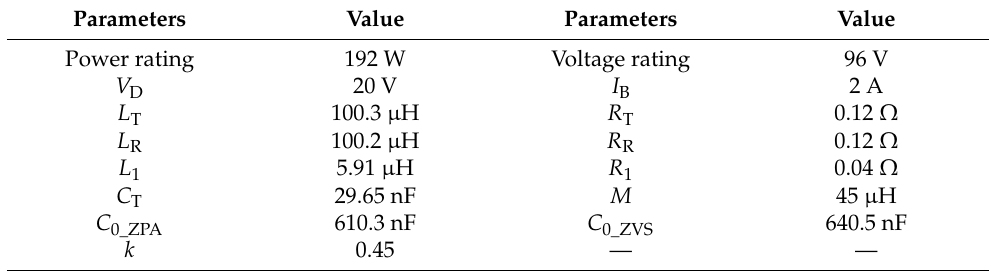
Table 5. Experimental circuit parameters of the proposed CLC/N compensated WPT system.